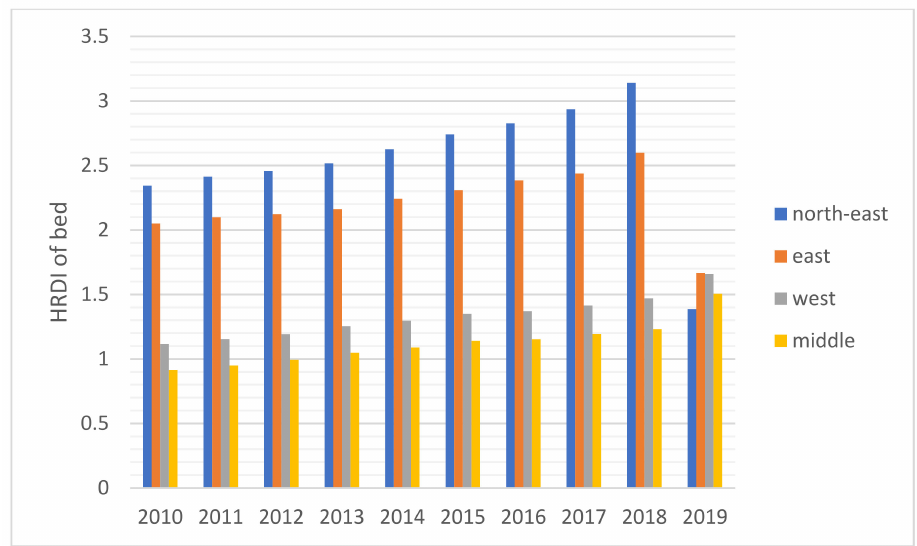
Figure 3. The HRDI of the health resources in beds when dividing China into four areas.